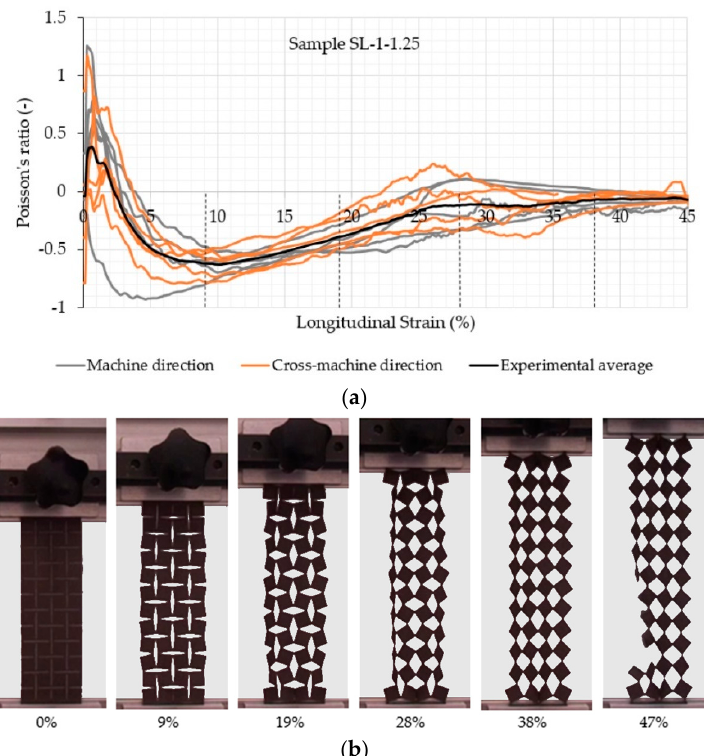
Figure 5. ( a ) Evolution of the Poisson’s ratio with the longitudinal strain of the auxetic sample SL-1-1.25 and ( b ) fabric deformation at different longitudinal strains during tensile testing in the machine direction.